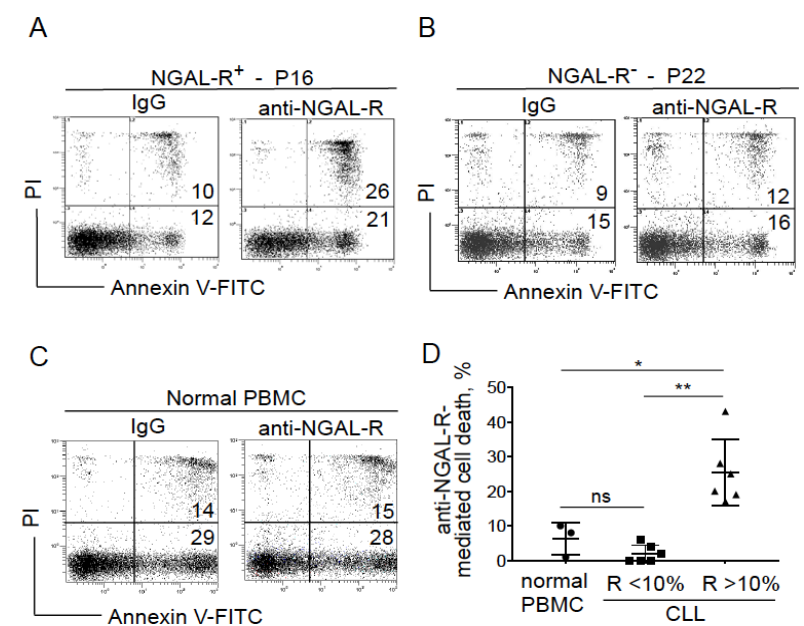
Figure 4. Anti-NGAL-R antibodies induce the death in CLL cells. ( A – C ) Representative cytograms of ( A ) NGAL-R + CLL cells (44%; P16), ( B ) NGAL-R - CLL cells (0%; P22) and ( C ) normal PBMCs cultured for 24 h in the presence or absence of 20 μg/mL anti-NGAL-R antibodies or rabbit IgG (isotype control); detection of apoptotic cells after annexin-V-FITC/PI staining and flow cytometry. Results are as log PI fluorescence intensity ( y -axis) vs. log annexin-V-FITC fluorescence intensity ( x -axis). The percentage of annexin-V-positive cells is shown. ( D ) Quantification of anti-NGAL-R-mediated survival levels in PBMCs from healthy individuals and CLL cells from untreated patients. The percentage of anti-NGAL-R-mediated survival is determined by subtracting the percentage of annexin-positive cells in the presence of rabbit IgG from the percentage of annexin-positive cells in the presence of anti-NGAL-R Ab. The data are presented as mean ± SD (normal PBMCs, n = 3; CLL cells, n = 12, with n = 6 NGAL-R + (≥10%) and n = 6 NGAL-R − (<10%); Statistical relevance was assessed with the unpaired t -test; not significant (ns); * p < 0.05; ** p <